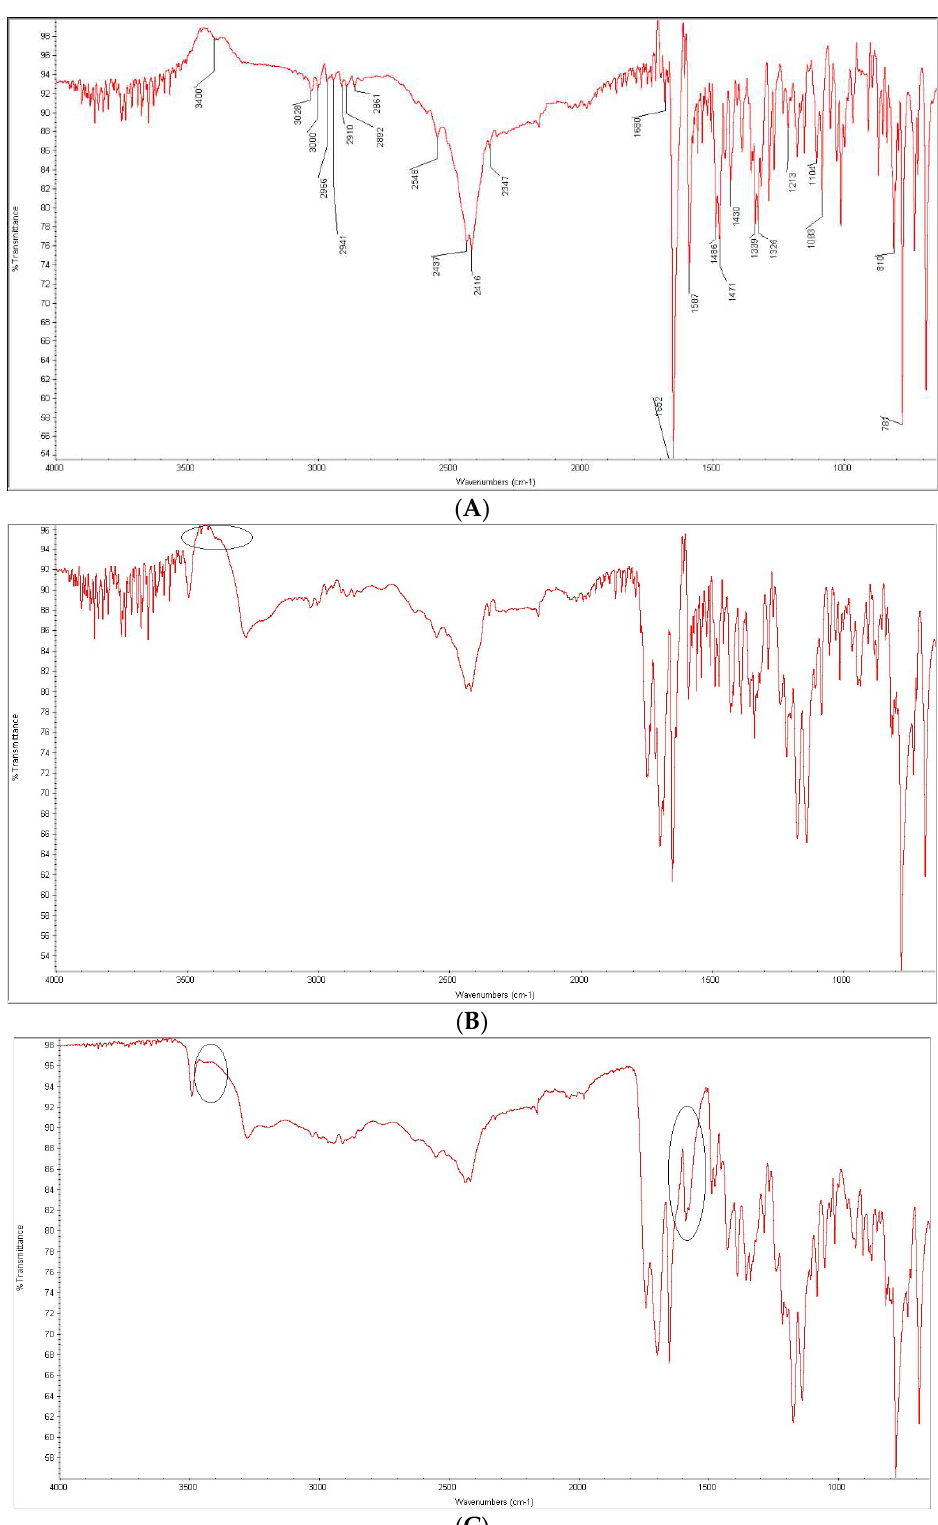
Figure 13. FT-IR spectra of azelastine (AZE) as a bulk ( A ) and in the mixtures with citric acid (CA): non-stressed mixture ( B ) and the mixture stressed with high temperature and humidity ( C ). When the mixture of AZE and PVP was examined without any stress, the peak of AZE at ca. 3400 cm −1 was overlapped with the signals of OH groups of PVA at 3600–3300 cm −1 (Figure 14A,B). When UV/VIS light was used for this mixture, a new band at 1727